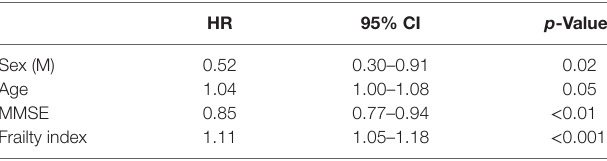
TaBle 3 | Cox regression analysis of factors predicting MCI conversion to AD